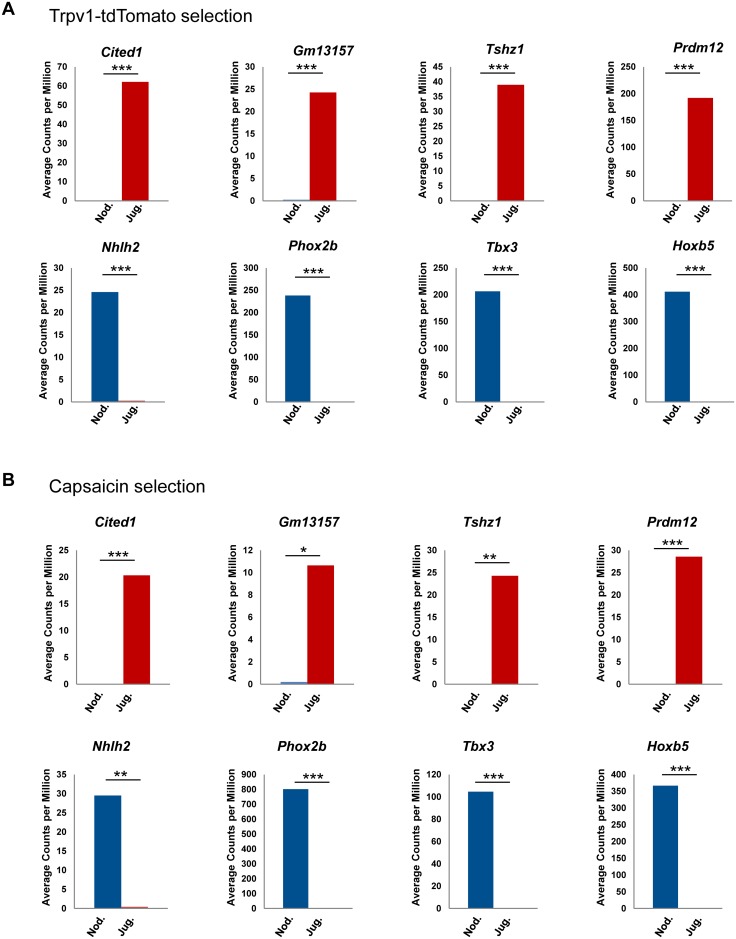
RNA sequencing revealed distinct expression of transcription factors between nodose and jugular C-fiber neurons.(A) Transcription factors differentially expressed in nodose and jugular C-fiber neurons from the Trpv1 selection. Y-axis indicates average of normalized counts per million (CPM) from Trpv1-tdTomato selection. Blue indicates nodose, red indicates jugular C-fiber neurons. P values were calculated based on group comparison. * p value ≤ 0.05; ** p value ≤ 0.01; *** p value ≤ 0.001. (B) Transcription factors differentially expressed in nodose and jugular C-fiber neurons from the capsaicin selection. Y-axis indicates average CPM from capsaicin selection. Blue indicates nodose, red indicates jugular C-fiber neurons. P values were calculated based on group comparison. * p value ≤ 0.05; ** p value ≤ 0.01; *** p value ≤ 0.001.